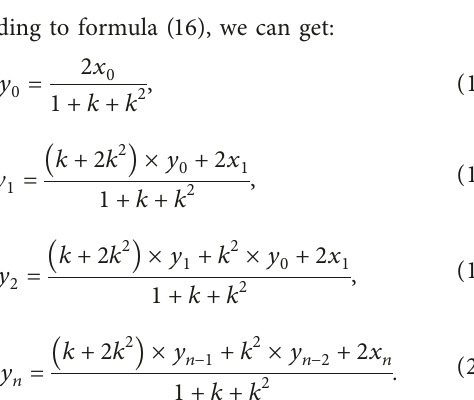
Figure 6: Flowchart of the crawler